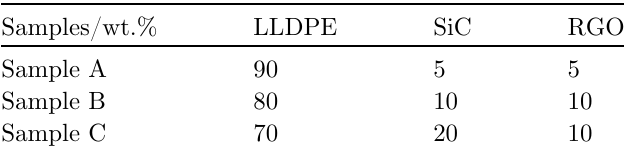
Table 1. RGO-SiC-LLDPE composites sample code.